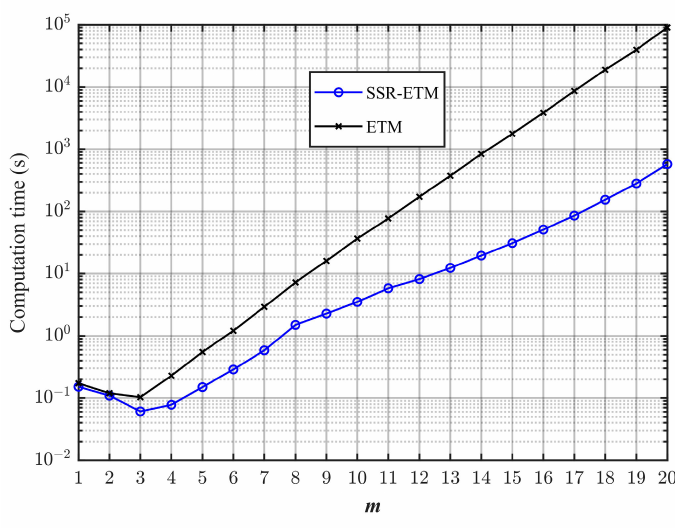
Figure 4. Computation time of the two methods for the monotonic